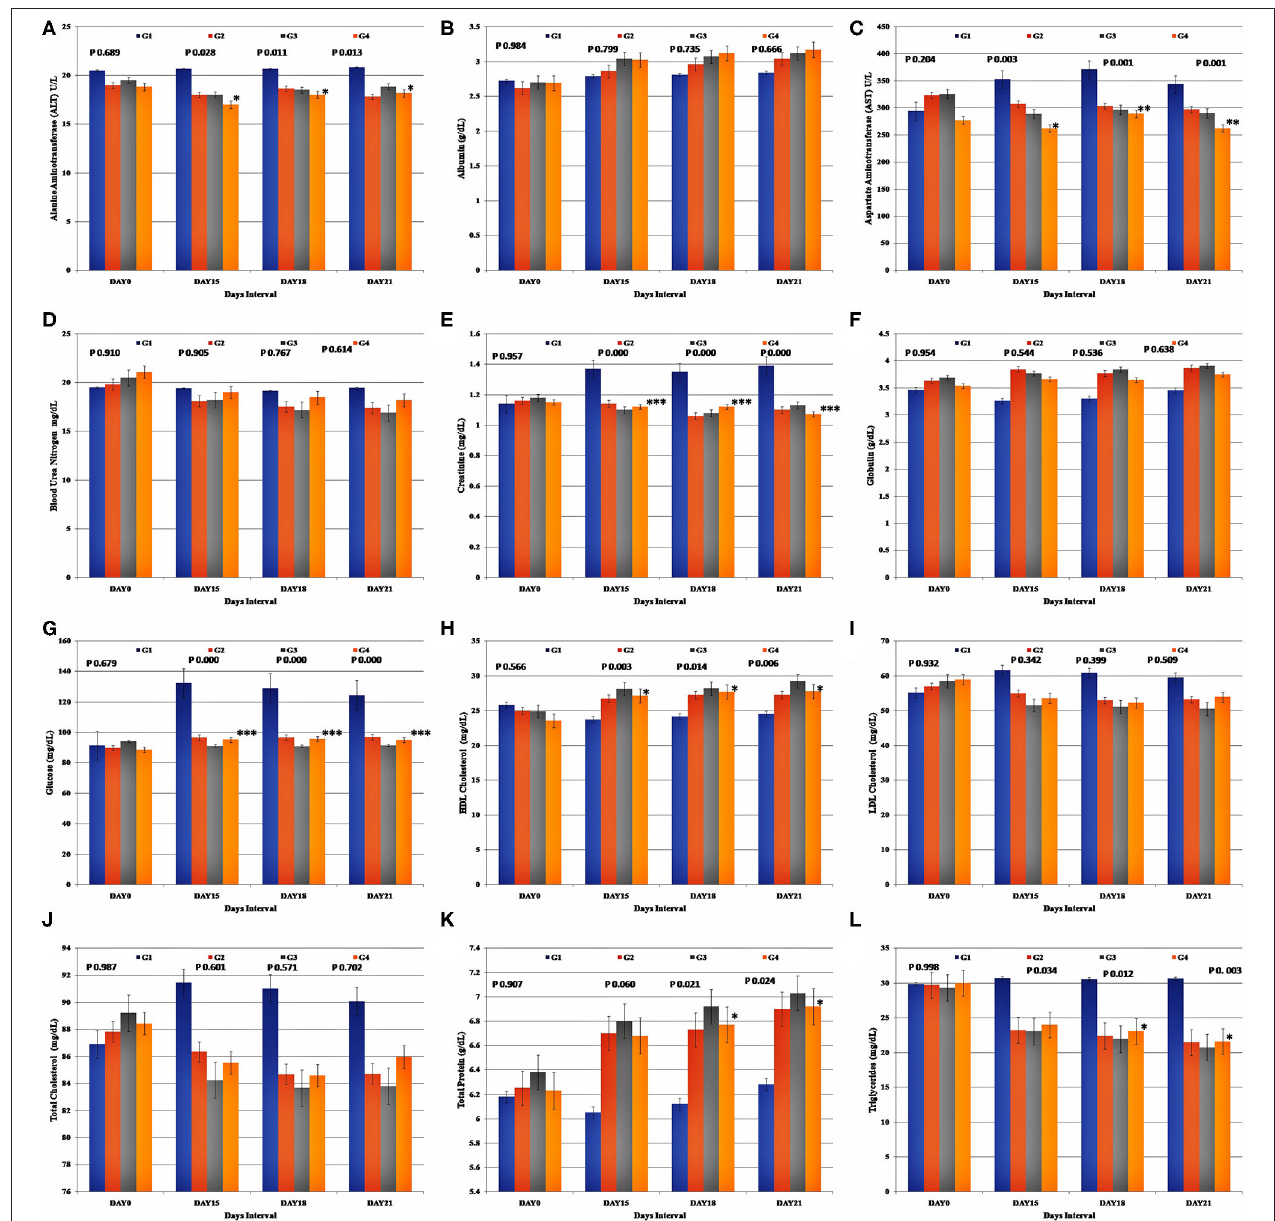
FIGURE 5 | Representation of the biochemical assessment results for each study group. Group-specific results obtained for (A) Alanine Aminotransferase (ALT), (B) Albumin, (C) Aspartate Aminotransferase (AST), (D) Blood Urea Nitrogen (BUN), (E) Creatinine, (F) Globulin, (G) Glucose, (H) HDL Cholesterol, (I) LDL Cholesterol, (J) Total Cholesterol, (K) Total Protein, and (L)